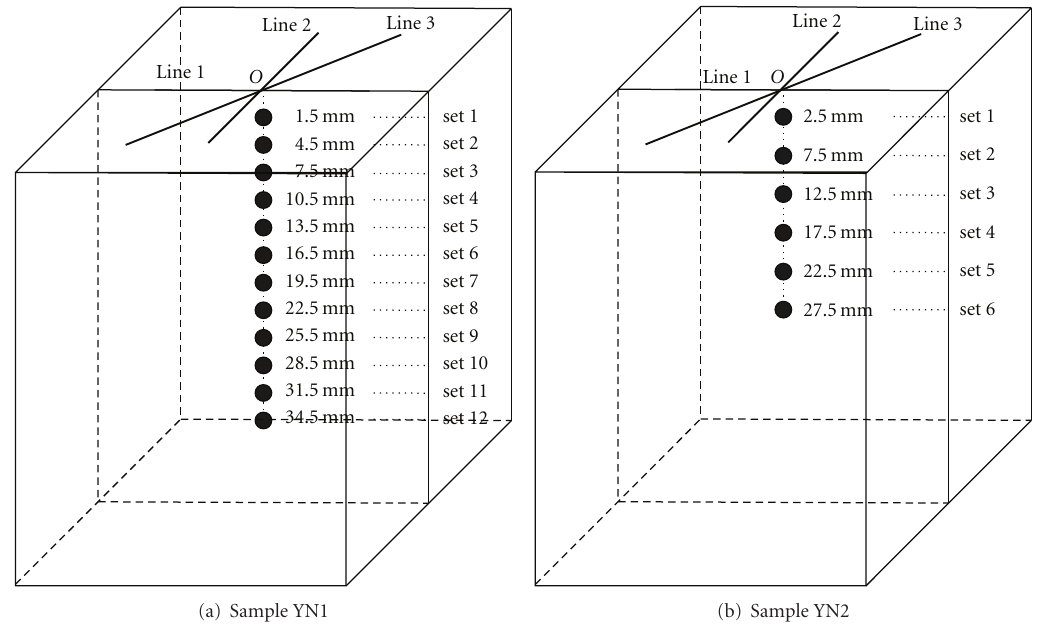
Figure 7: The diagram of apparent resistivity sets corresponding to e ff ective depths. Because the e ff ective depth of Wenner- α array was evaluated to be about 0.5 time of electrode spacing [36, 37], the 12 apparent resistivity sets were corresponding to the e ff ective depths of about 1.5mm, 4.5 mm, 7.5mm, 10.5 mm, 13.5mm, 16.5 mm, 19.5 mm, 22.5mm, 25.5 mm, 28.5 mm, 31.5mm, and 34.5mm for sample YN1, and 6 ones were corresponding to the e ff ective depths of about 2.5 mm, 7.5mm, 12.5 mm, 17.5 mm, 22.5mm, and 27.5 mm for sample YN2 according to Figure